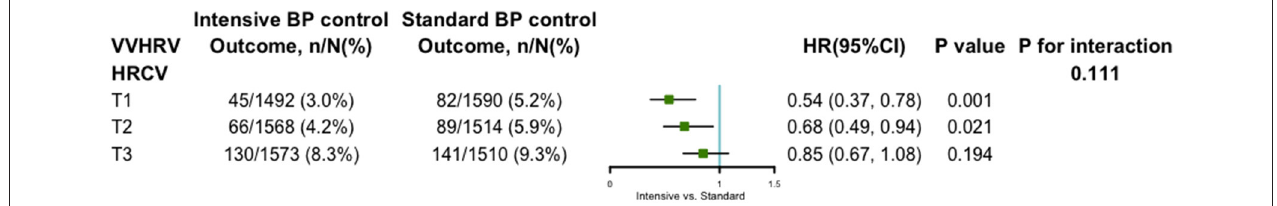
FIGURE 4 | The impact of intensive vs. standard BP control on composite cardiovascular outcomes stratified by the tertiles of CV in heart rate. All covariables in Model 3 were adjusted.